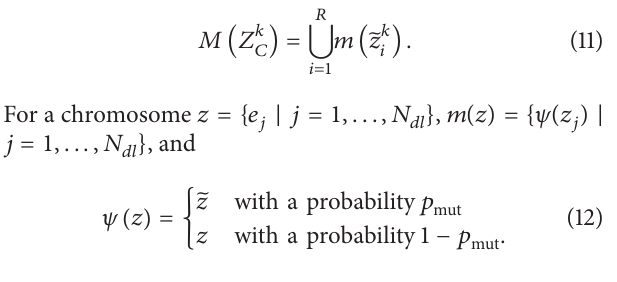
Figure 2: Best, worst, and mean values of fitness function ( plane